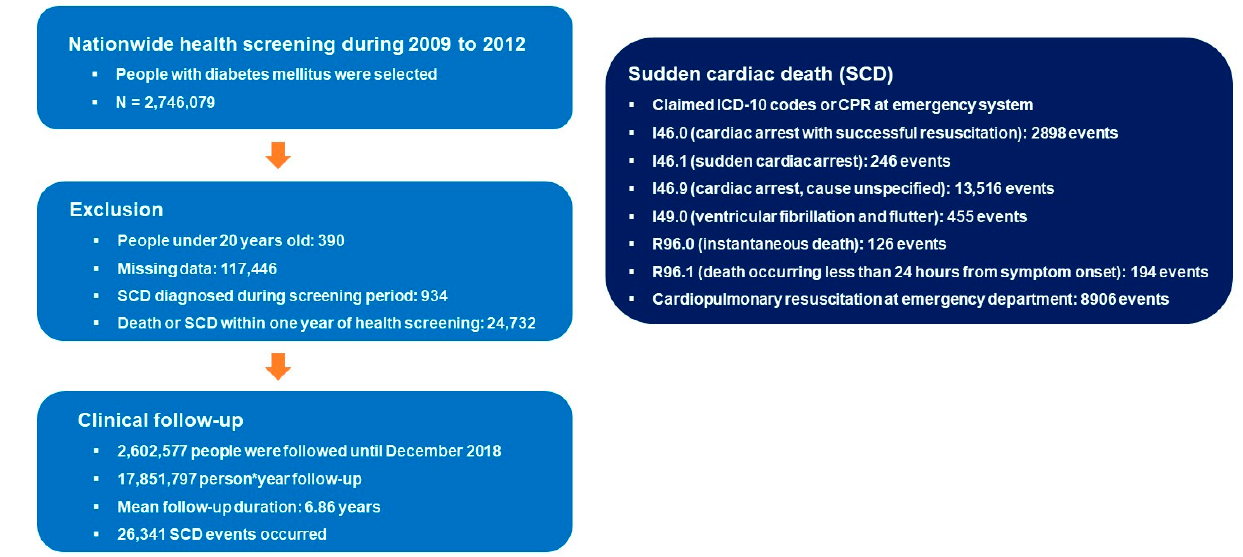
Figure 1. Flow of the study. ICD-10: International Classification of Disease, tenth edition; SCD: sudden cardiac death.